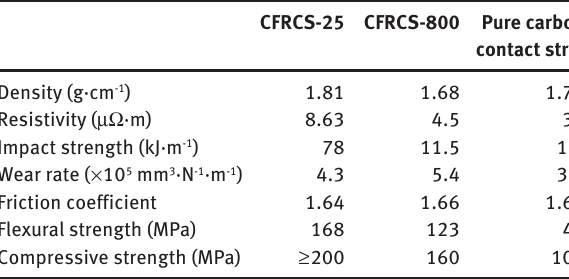
Table 1 Element composition on worn surface. Table 2 Different contact strips performance